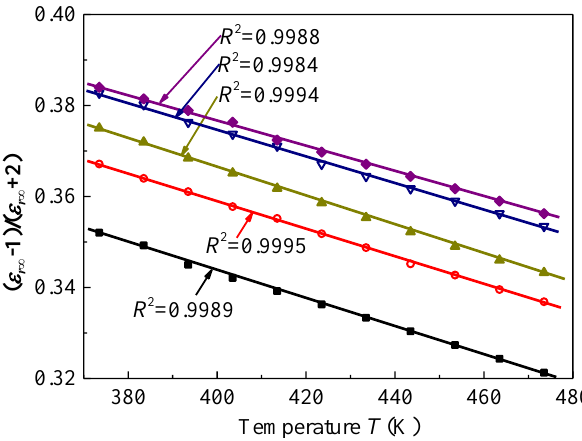
Figure 7. ( ε r ∞ − 1) / ( ε r ∞ + 2) as a function of temperature T . Symbols and solid curves represent the data obtained experimentally and numerically, respectively. R 2 represents the goodness of fit. (cid:4) : Pristine, : irradiated at 145 ◦ C for 900 h, (cid:78) : irradiated at 145 ◦ C for 1500 h, (cid:53) : irradiated at 185 ◦ C for 900 h, (cid:7) : irradiated at 185 ◦ C for 1500